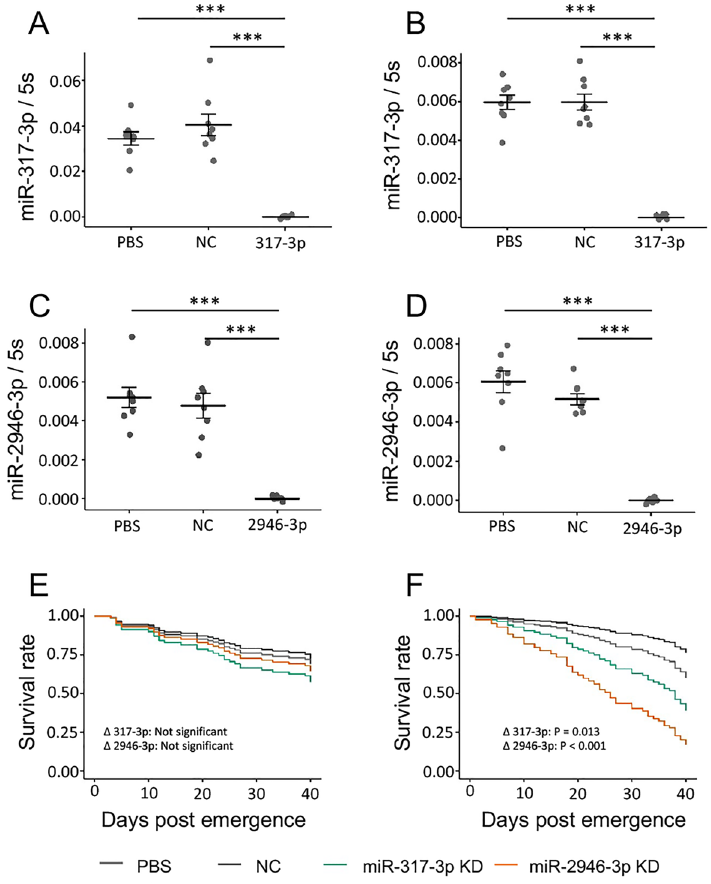
Figure 8. Inhibition of miR-317-3p and miR-2946-3p and its effect on lifespan of adult Ae. aegypti females. ( A ) and ( B ) Effect of miRNA inhibition on relative expression of miR-317-3p in WB2.tet and WB2 mosquitoes, respectively. ( C ) and ( D ) Effect of miRNA inhibition on relative expression of miR-2946-3p in WB2.tet and WB2 mosquitoes, respectively. ( E ) and ( F ) Effect of miRNA inhibition on longevity of WB2.tet and WB2 mosquitoes, respectively. KD, knock down. WB2.tet survival was not significantly affected by miRNA inhibition. WB2 survival was significantly affected by inhibition of miR-2946-3p (Cox ph, p < 0.0001) and miR-317-3p (Cox ph, p =